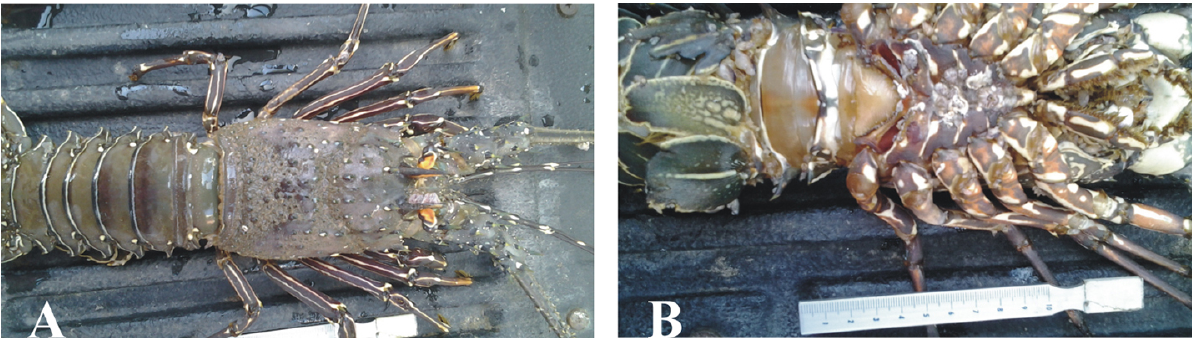
Figure 3. Large specimens of Balanus trigonus Darwin, 1854, observed on the spiny lobsters Panulirus gracilis Streets, 1871 (CL 74 mm). A. On the right carapace frontal horn. B. On the sternal